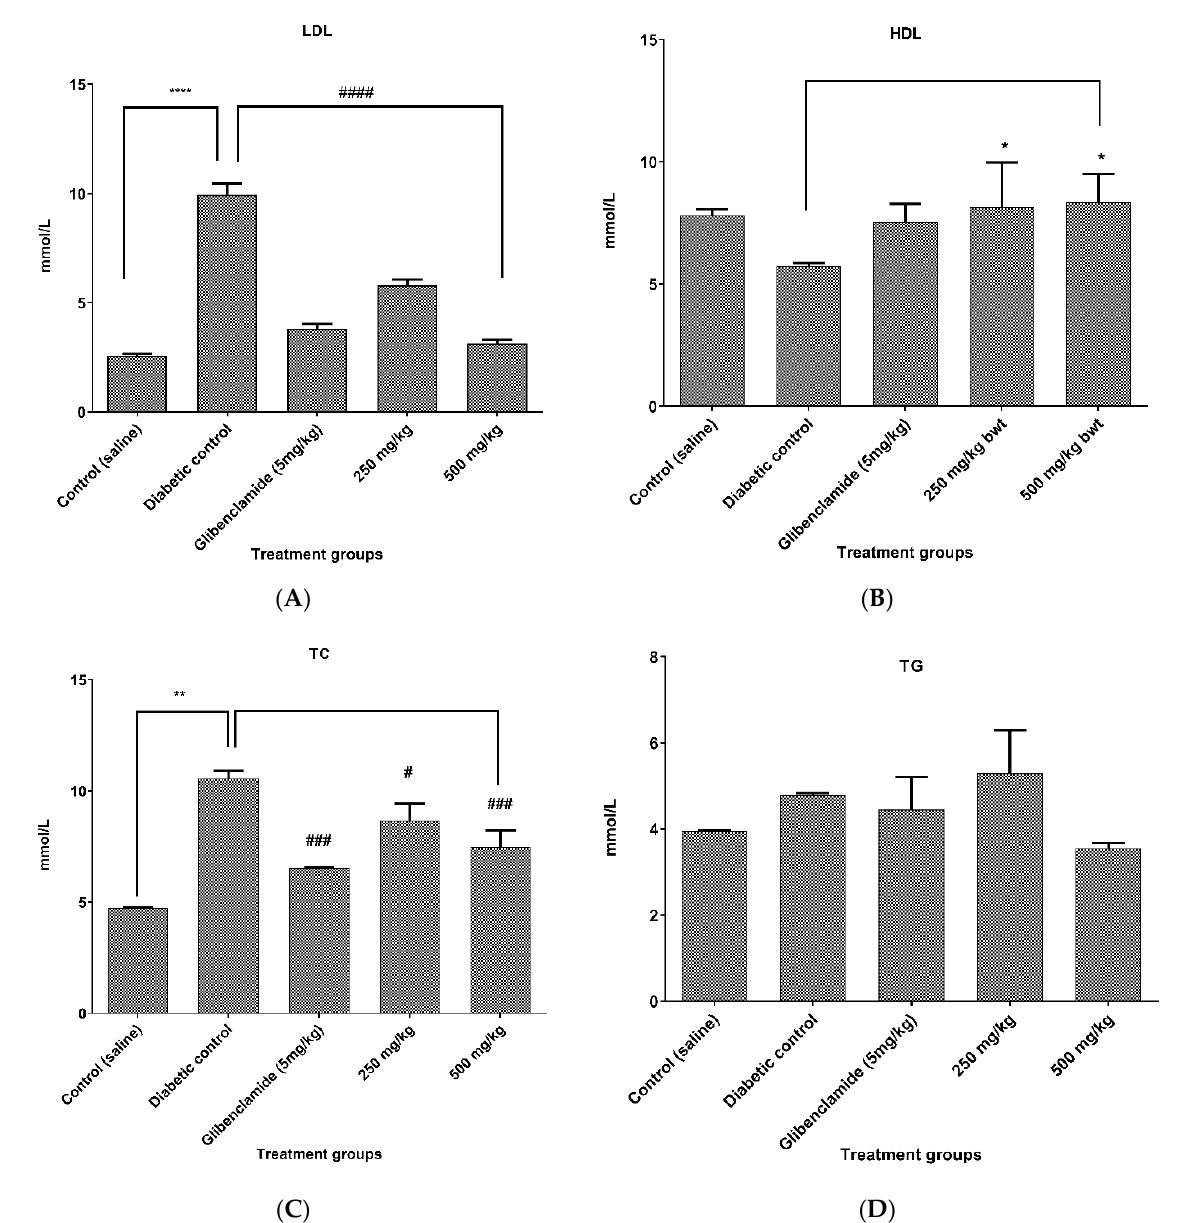
Figure 3. Effect of CILEx on serum lipid profiles: ( A ) low-density lipoprotein (LDL), ( B ) high-density lipoprotein (HDL), ( C ) total cholesterol (TC), and ( D ) triglyceride levels of different treatment groups. Glibenclamide (5 mg/kg body weight) was used as a positive control. Data were represented as mean ± SD of four animals, and were analyzed via one-way ANOVA using Tukey’s multiple range post hoc test. (*, **, ****) over the bar denotes significant different from control, and (#, ###, ####) indicates significant difference from diabetic control p < 0.05 was considered to be significant.